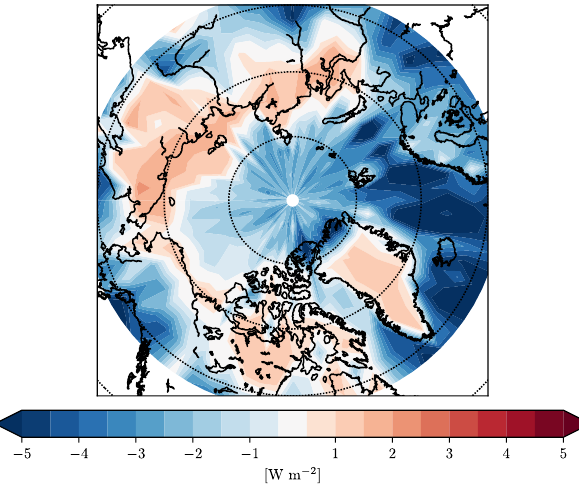
Figure 7. The net direct radiative effect over the Arctic in April assuming externally mixed